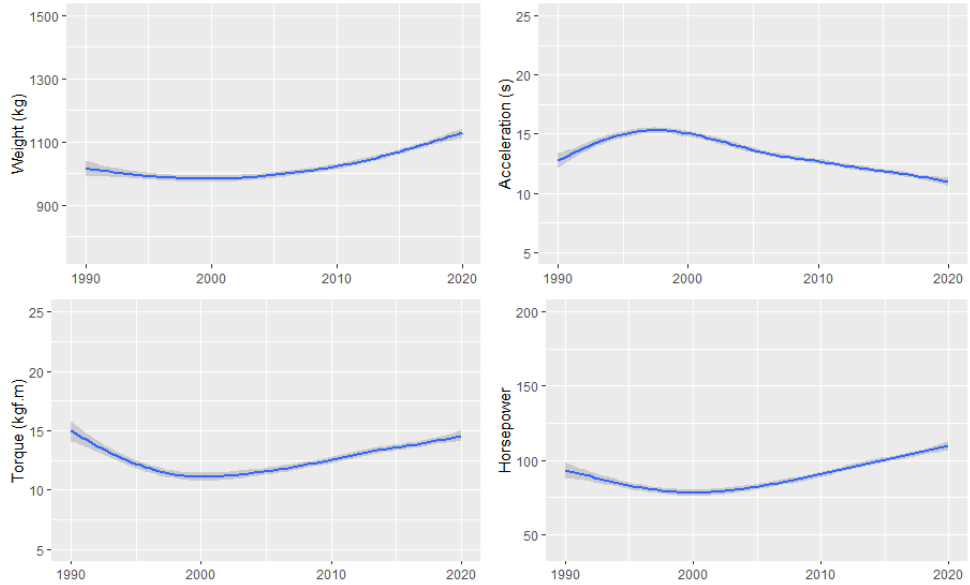
Figure 3. Evolution of key LDV parameters used in the regression models from 1990 to 2020 (hori- zontal axis).